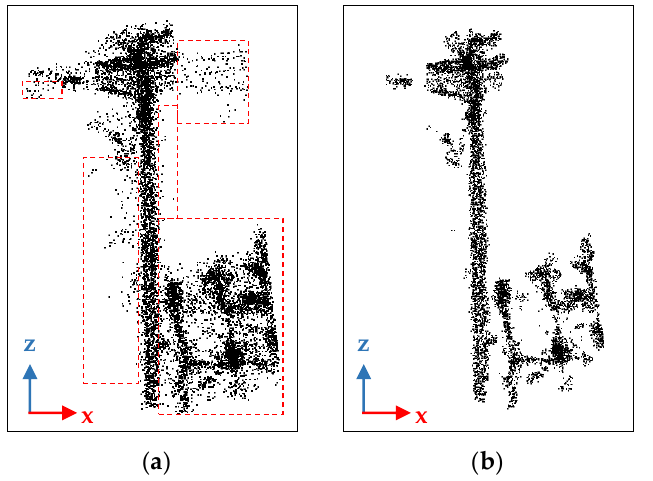
Figure 7. Buffer point cloud and point cloud denoising results: ( a ) Projection of buffer point cloud to XZ plane. ( b ) The projection of the point cloud to the XZ plane after denoising.